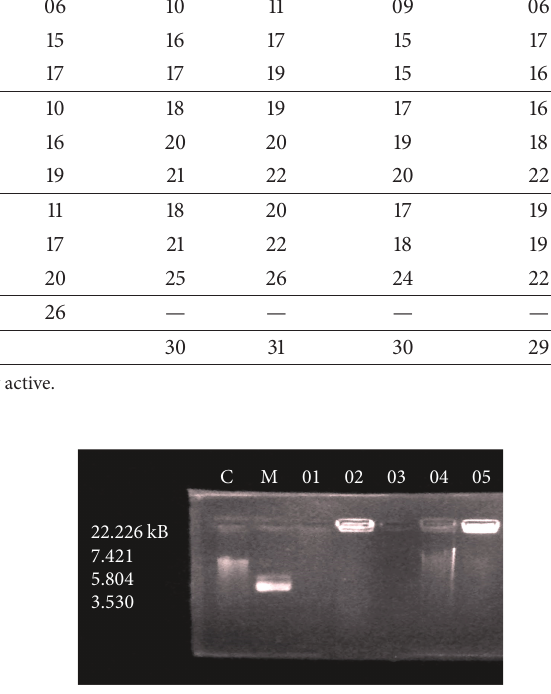
Figure 3: DNA cleavage activity studies of Cu(II), Ni(II), Co(II), Cd(II), and Hg(II) (lanes-O1, O2, O3, O4, and O5) complexes,